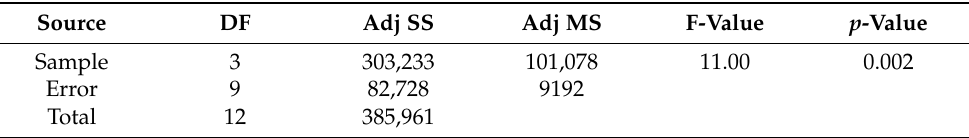
Table 5. One-way ANOVA based on the samples’ abundances. Significance level α = 0.05. DF,